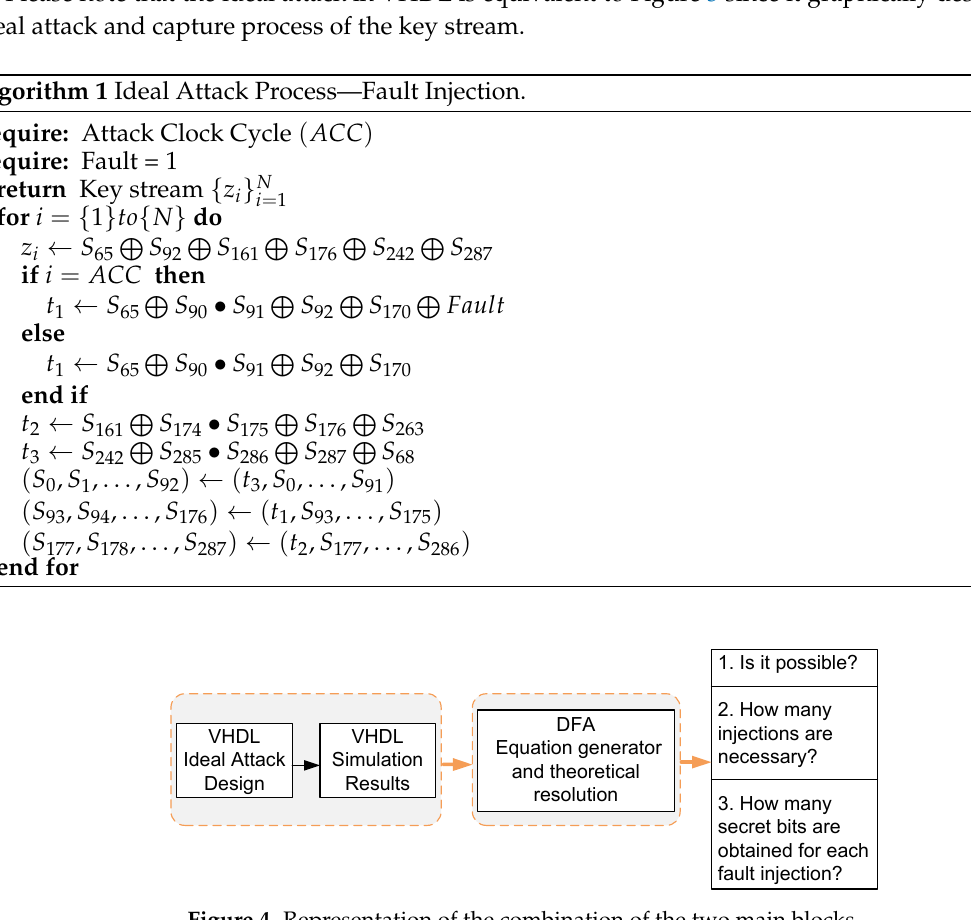
Figure 4. Representation of the combination of the two main